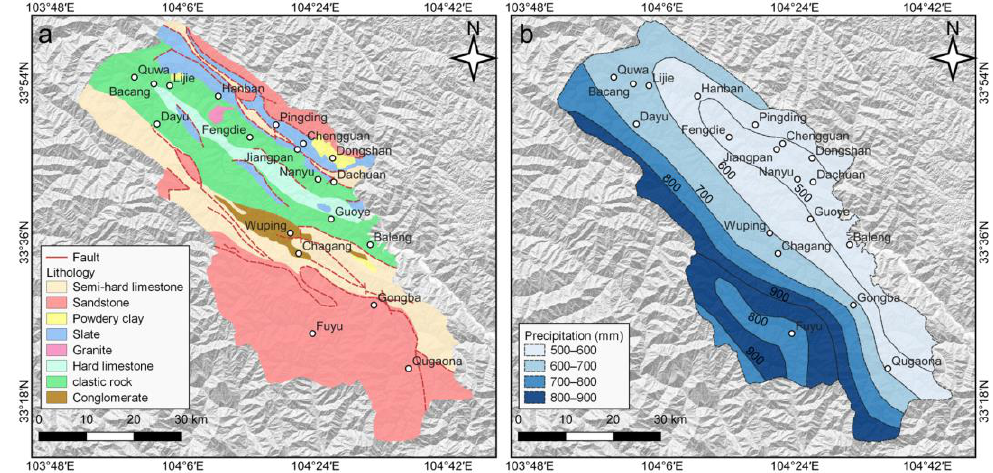
Figure 2. Geographic map ( a ) and average annual precipitation map ( b ) of Zhouqu County [43].